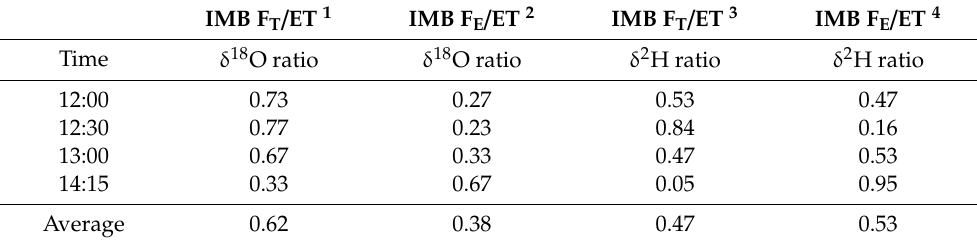
Table 3. Isotope mass balances flux ratios quantified from Big Cypress, FL field